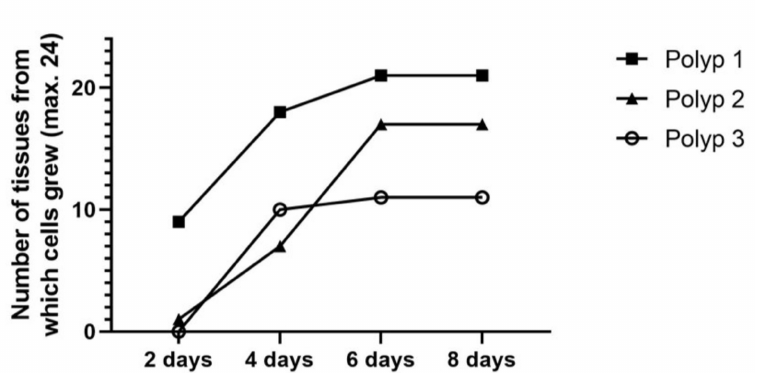
Figure 1. Cumulative number of tissue pieces from which cells grew out. Tissues from 3 patients were taken for the isolation of epithelial cells. Per sample, 24 small-cut pieces of tissue from each patient were used for the outgrowth of epithelial cells. The cumulative number of tissue samples from which cells grew out was assessed every 2 days. Outgrowth of 9, 18, 21, and 21 (Polyp 1); of 1, 7, 17, and 17 (Polyp 2); and of 0, 10, 11, and 11 (Polyp 3) of the 24 small-cut tissue pieces was noted on Days 2, 4, 6, and 8, respectively.